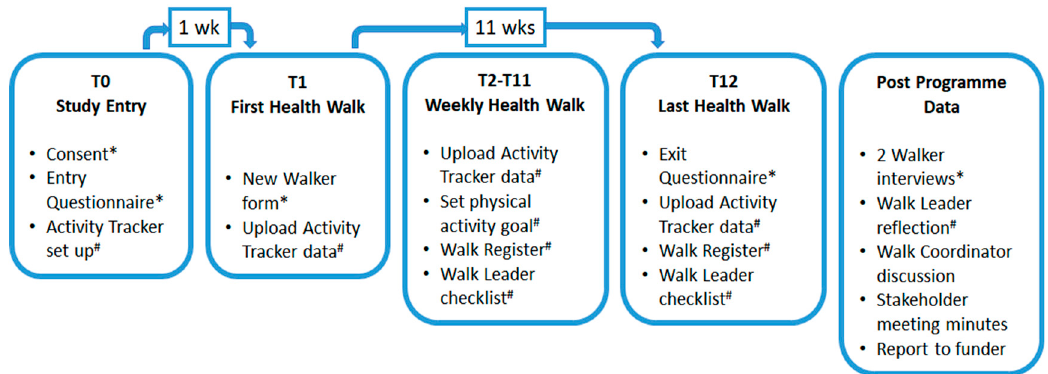
Figure 1. Data collection and study procedures for mixed methods feasibility study of a 12-week group outdoor health walk using activity tracker technology. Data from * Walkers or # Walk Leader.